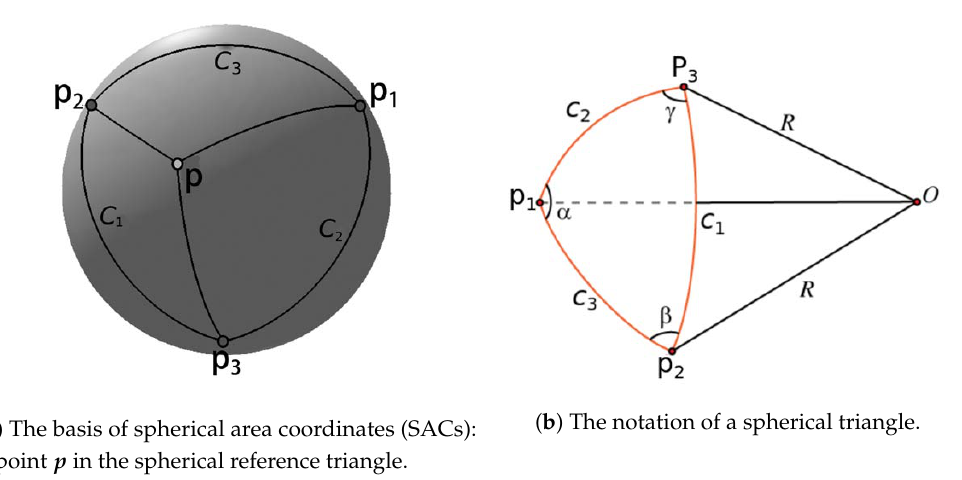
Figure 6. SAC spherical reference